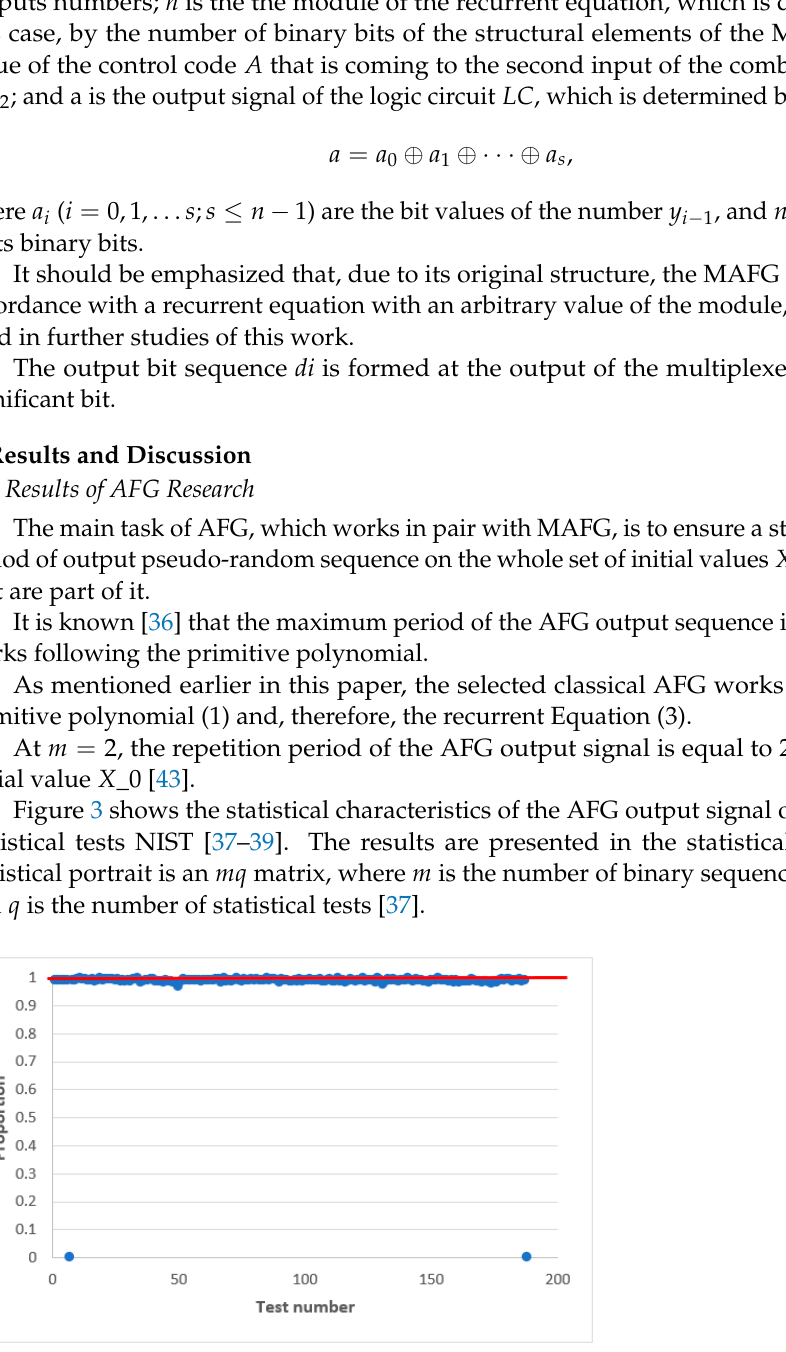
Figure 3. Statistical portrait of the AFG output sequence.